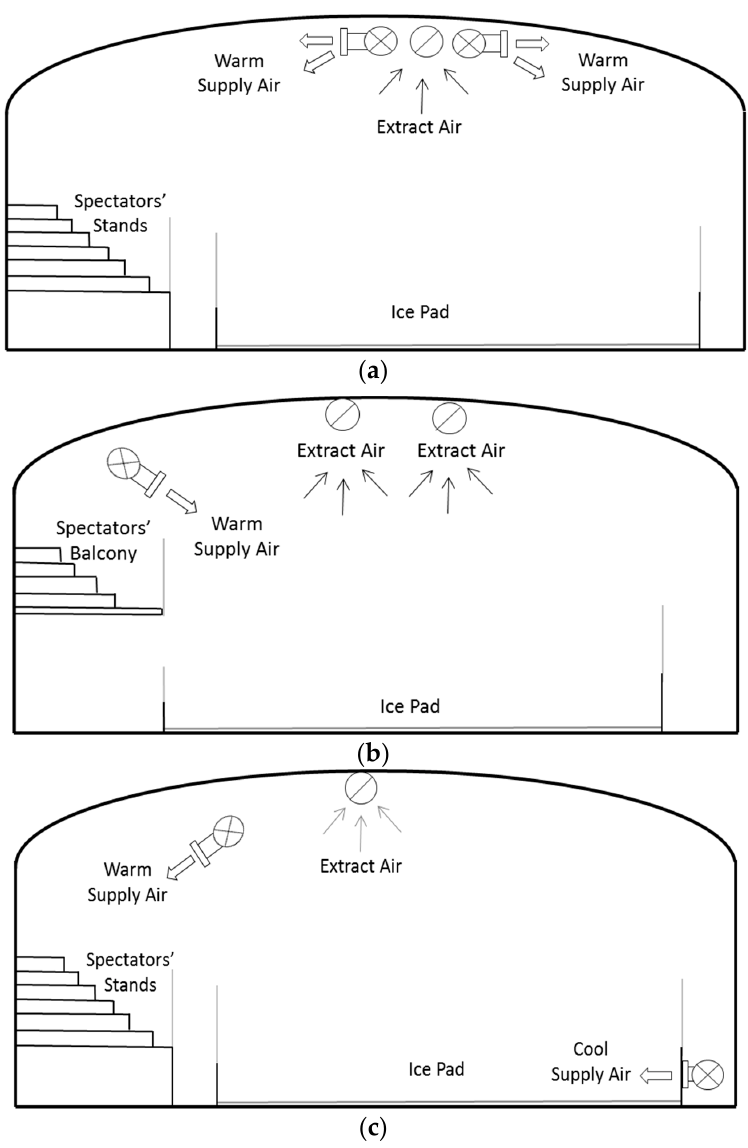
Figure 2. Air distributions corresponding to the measured temperature gradients: ( a ) A; ( b ) B; ( c ) C.